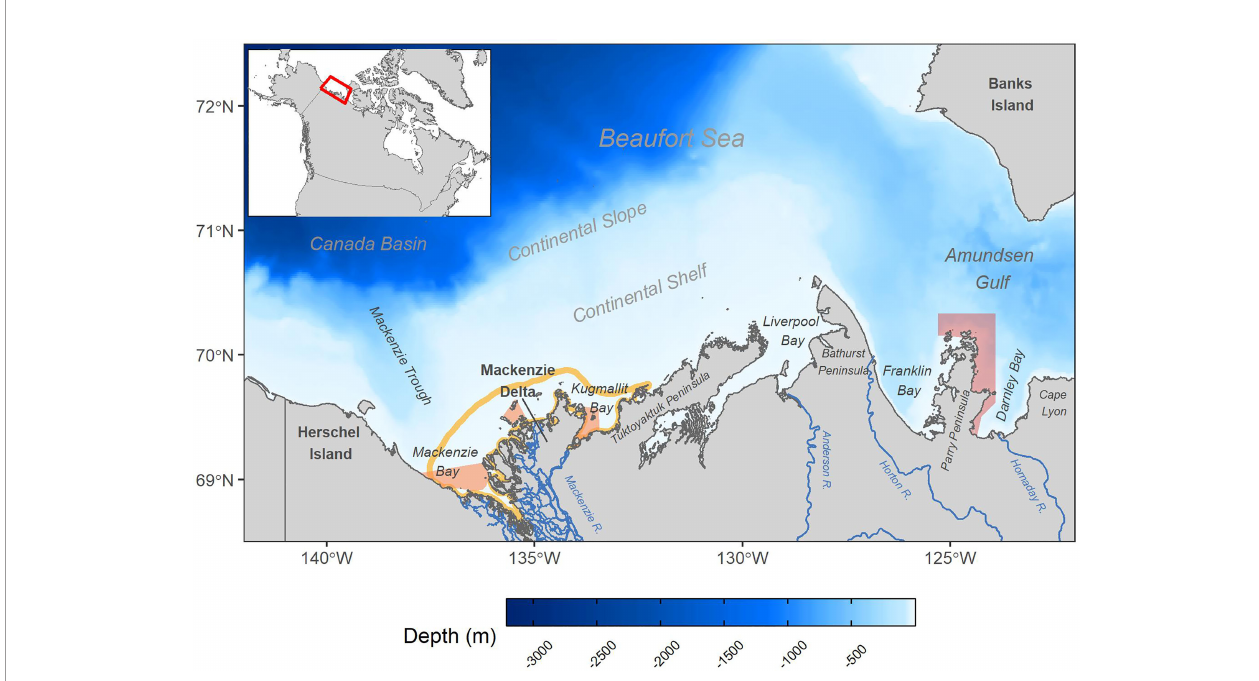
FIGURE 1 | Study area in the Eastern Beaufort Sea shown with bathymetry, notable physical features and freshwater inputs, Marine Protected Areas (MPAs) and location on inset map of Canada. The area of raised cloud albedo processing is shown as an orange outline around the Mackenzie Delta (see section 2.2.1).